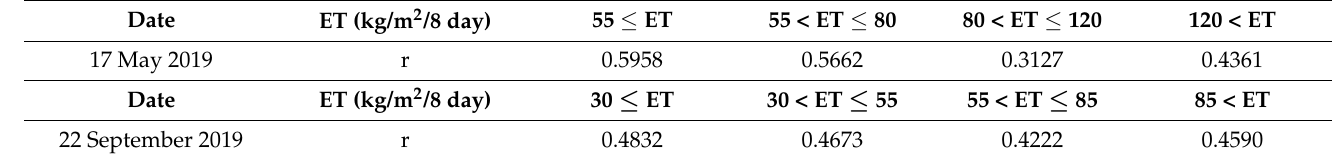
Table 2. The collection between measured and estimated SM in four groups with respect to the ET values.